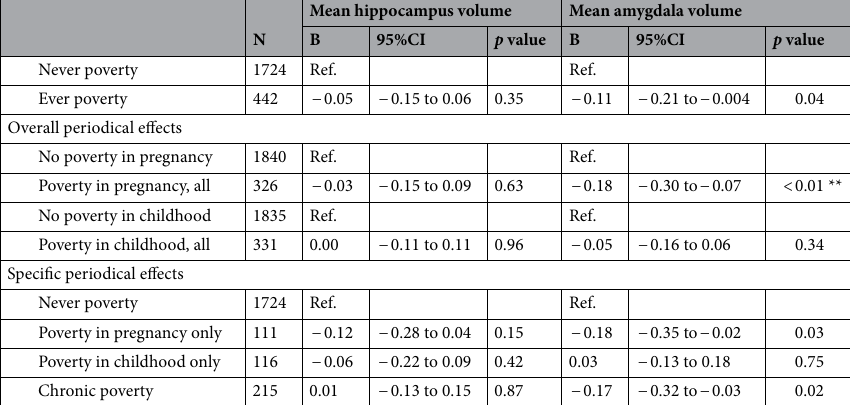
Table 3. The association of poverty with subcortical regional brain morphology (N = 2166). Models adjusted for child age at brain measurement, child sex, maternal ethnicity, maternal IQ, maternal educational attainment at pregnancy, maternal and paternal psychiatry symptoms at pregnancy and total intracranial volume. All brain measures of outcome are standardized. Ever poverty is a total of "poverty in pregnancy only", "poverty in childhood only" and "chronic poverty". ** indicates adjusted p value < 0.01. Adjusted p values are obtained by considering the multiple comparisons (four tests for ever, pragnant any and childhood any poverty and 12 tests (= four brain metrics × 3 timings of exposure) for pregnant, childhood and chronic poverty) with the Benjamini–Hochberg false discovery rate